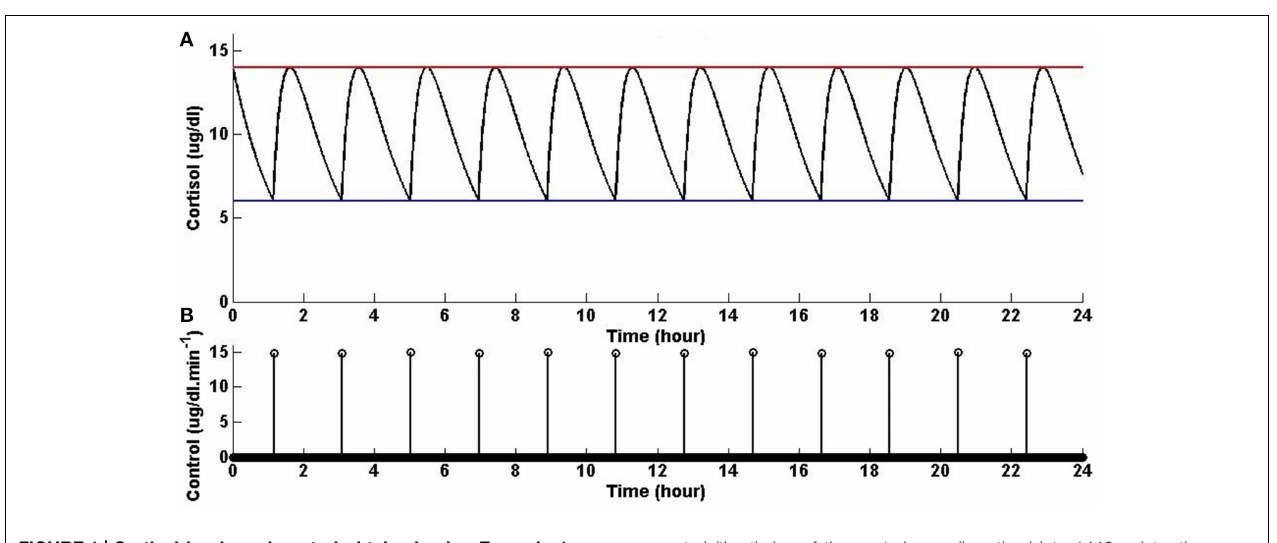
FIGURE 1 | Cortisol levels and control obtained using Example 1. (A) The top panel displays the optimal cortisol profile (black curve), constant upper bound (red curve), and constant lower bound (blue curve). (B) The bottom panel displays the optimal control. The optimization problem obtained 12 impulses over 24 h as the optimal